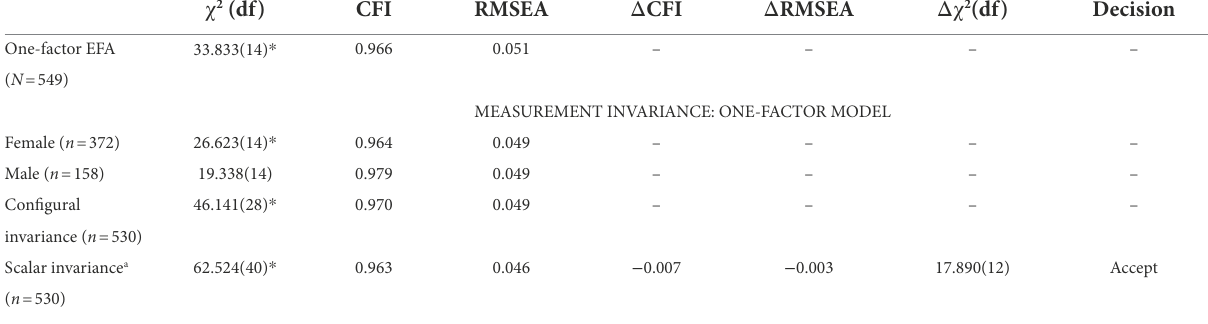
TABLE 3 Structural and measurement invariance model fit